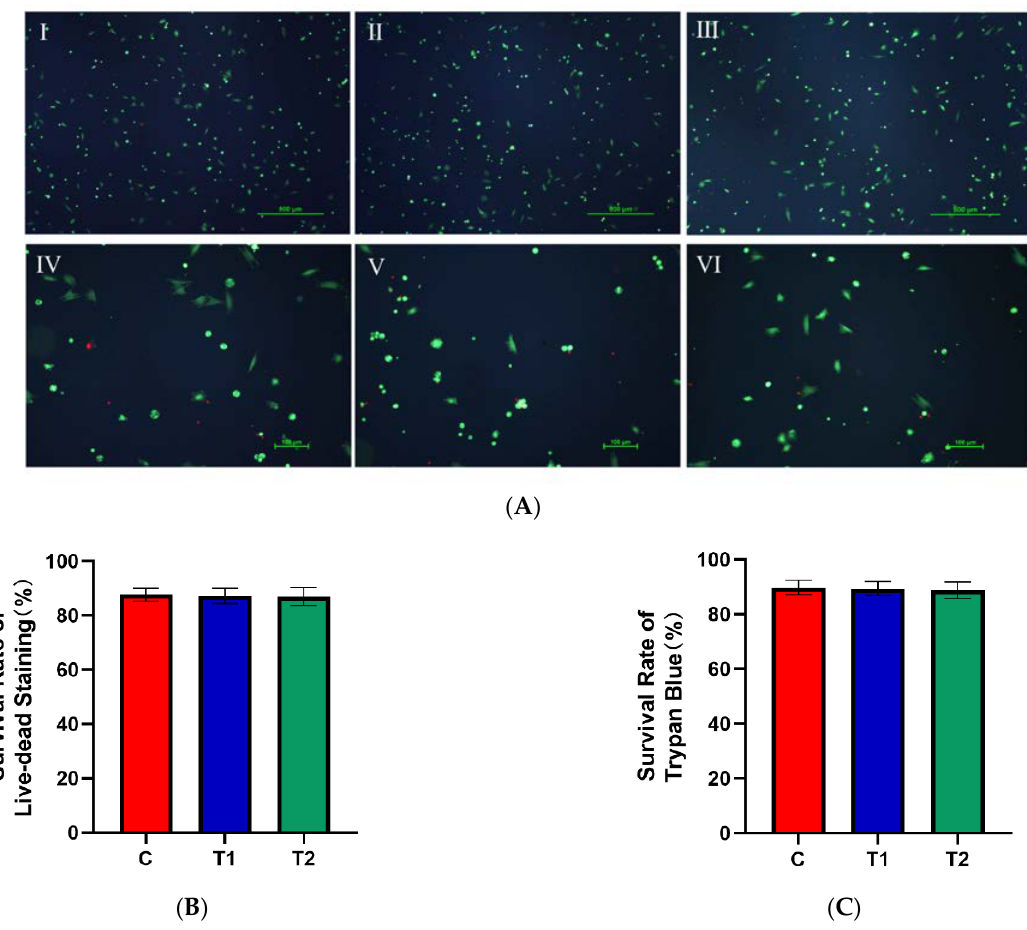
Figure 4. Effects of new cryopreservation strategy on the cell survival rate. ( A ) Live–dead staining results of dental pulp cells. Ⅰ : C group (×40); Ⅱ : T1 group (×40); Ⅲ: T2 group (×40); Ⅳ : C group (×100); Ⅴ : T1 group (×100); Ⅵ : T2 group (×100). ( B ) The survival rate of live–dead staining in each group. ( C ) The survival rate of Trypan Blue staining in each